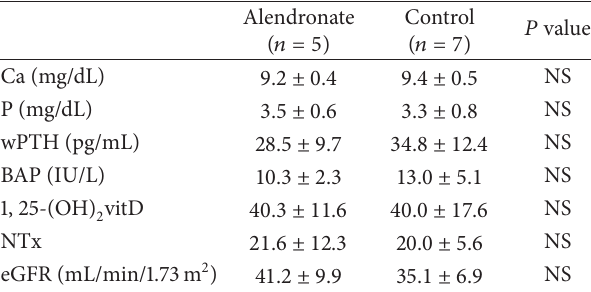
Table 2: Biochemical parameters and bone turnover markers at